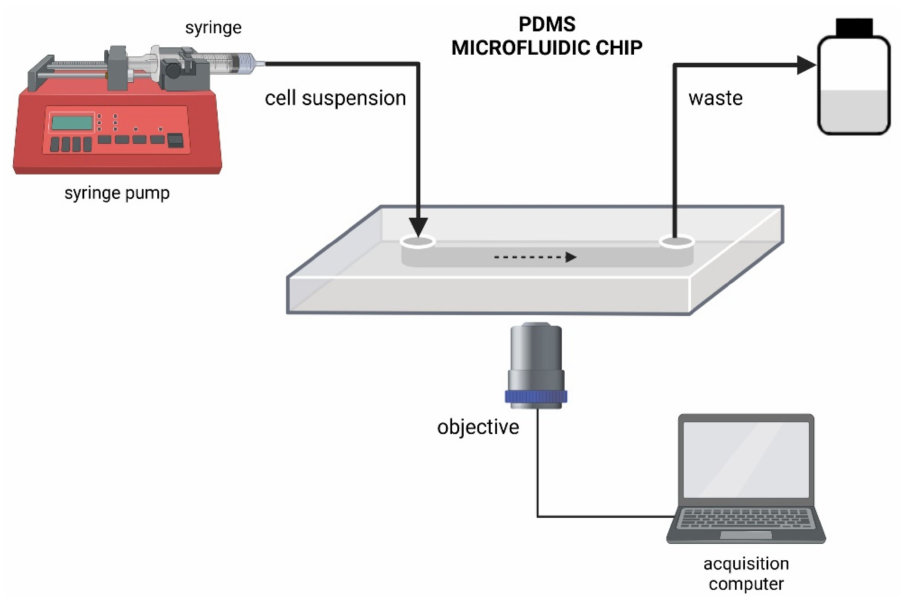
Figure 4. Schematic diagram of a microfluidic